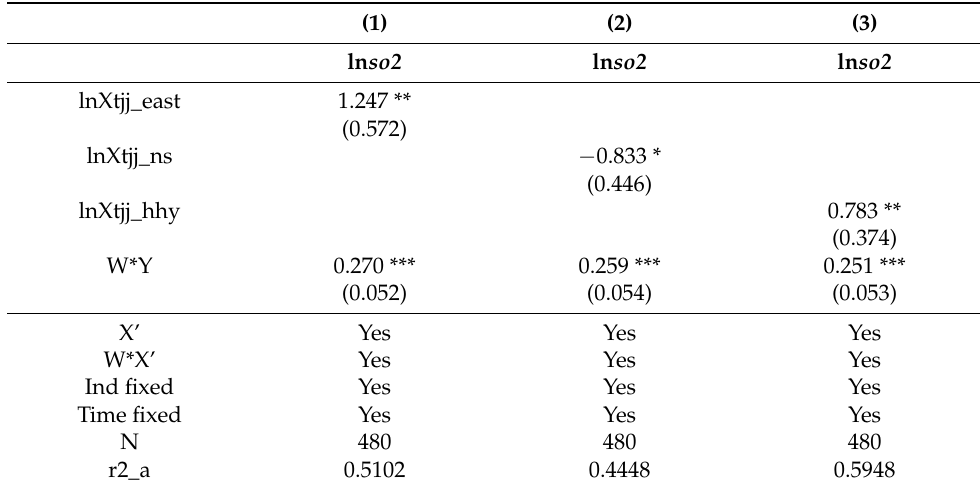
Table 5. The empirical results of regional